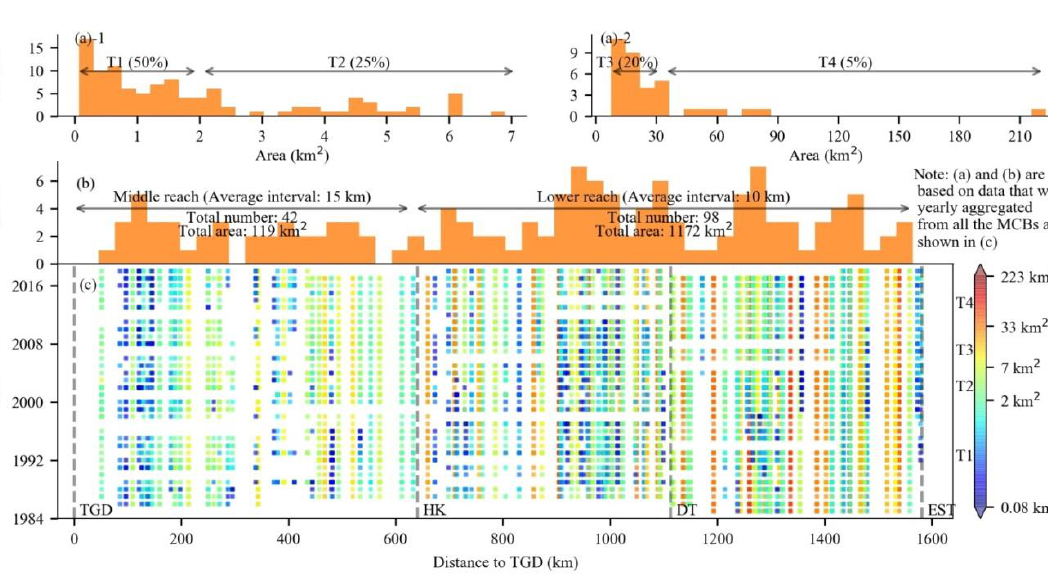
Table 2. Four different types of MCBs.